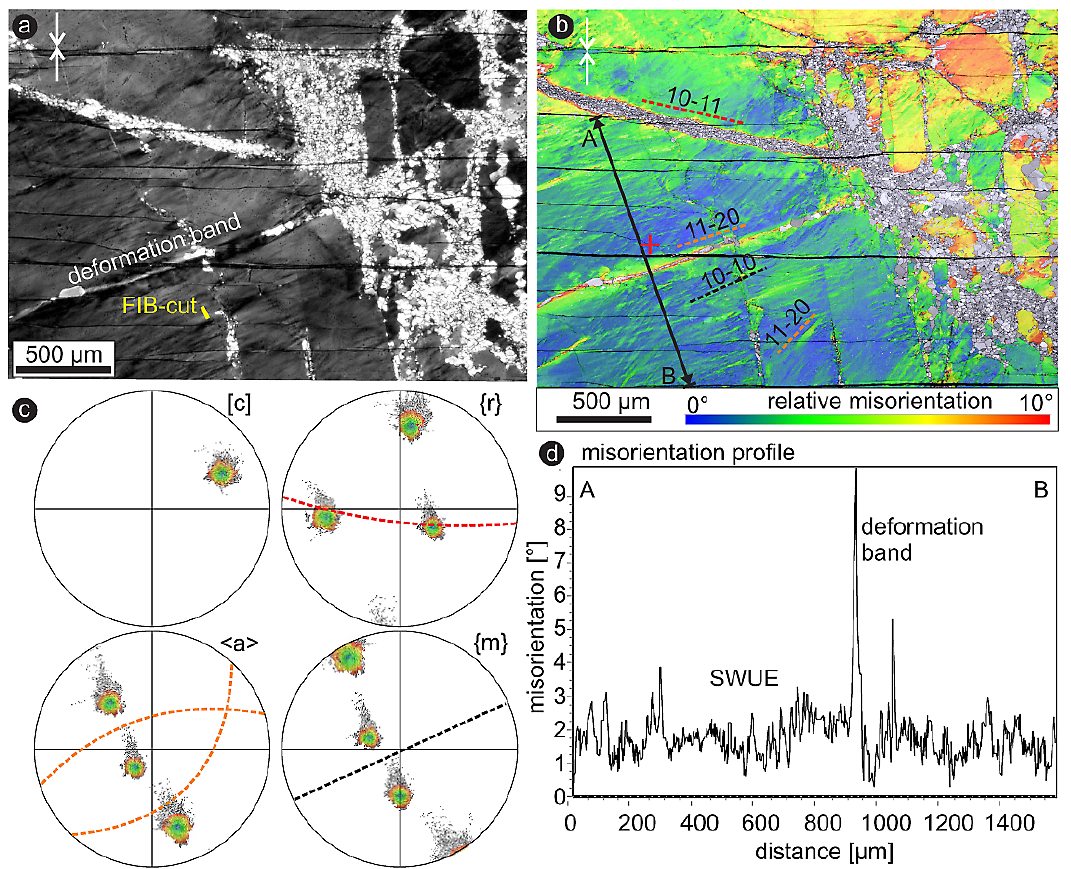
Fig. 6. Quartz microfabric after “kick and creep” experiment CR1-17, initially deformed at 400 ◦ C, 2GPa confining pressure, 10 − 4 s − 1 strain rate, and afterwards at 900 ◦ C, 2.5GPa confining pressure and approximately constant stress. The shortening direction is indicated by white arrows. (a) Polarized light micrograph showing strings of recrystallized grains, deformation bands and pervasive SWUE. Location of FIB cut TEM foil is marked by yellow rectangle. (b) EBSD map showing misorientation relative to reference point (red cross). Black line indicates location of misorientation profile displayed in (d) . (c) Pole figures showing crystallographic orientation of host grain. Crystallographic planes, which are traced in (b) , are indicated by great circles. (d) Misorientation relative to point A along yellow line displayed in (b) .